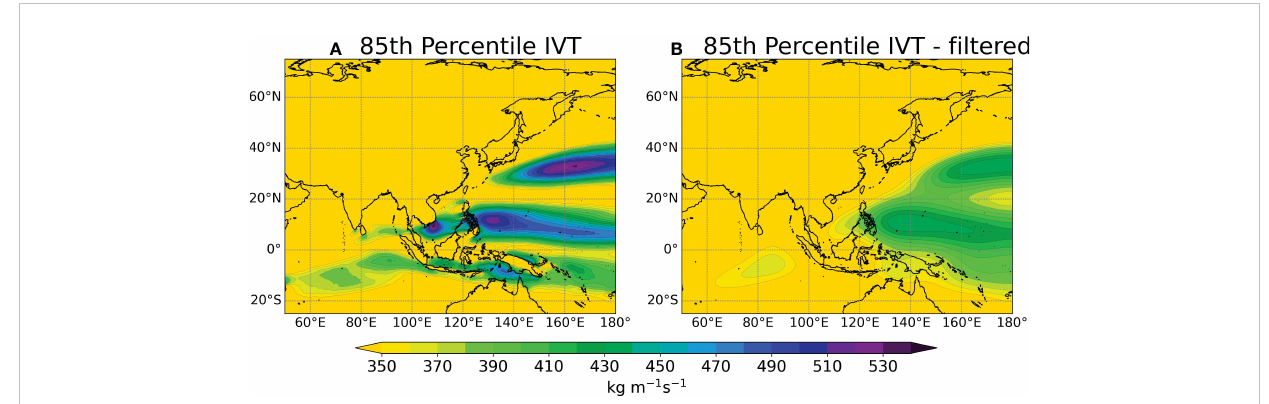
FIGURE 3 Spatial distribution of the 85 th percentile of IVT from October to March (ONDJFM) for the period 1951 – 2015: (A) Original distribution; (B) Filtered distribution used for the isolation of AR